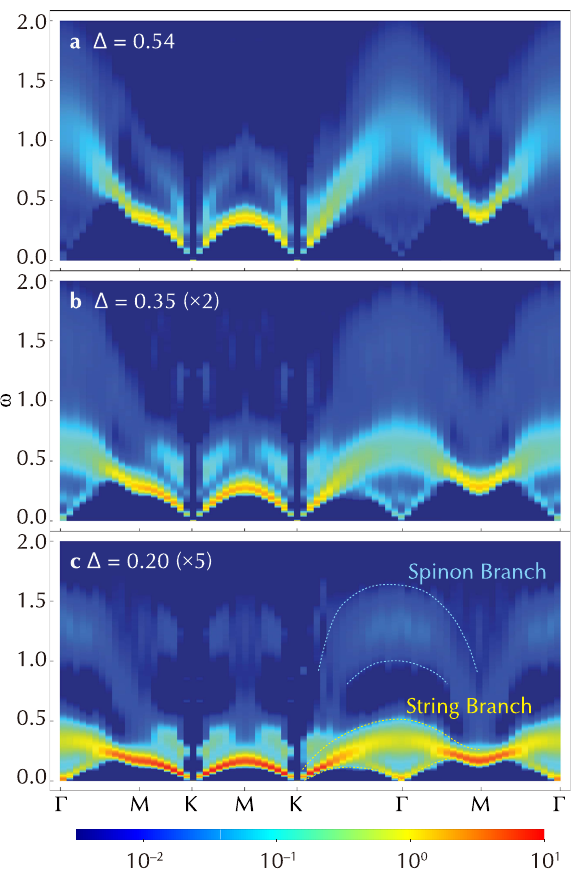
Fig. 1 The spectra at different transverse fi eld Δ . a The parameter Δ = 0.54 and J ′ = 0.05 corresponds to the material TMGO. b Δ = 0.35, J ′ = 0.35 and ( c ) Δ = 0.20, J ′ = 0.020 are for lower energy splitting. The circled areas in ( c ) demonstrate the splitting of two branches. The path taken in the Brillouin zone is speci fi ed in the inset of ( a ). The spectra are plotted in logarithmic scale to accommodate more details. For the plots in linear scale, see Supplementary Fig.